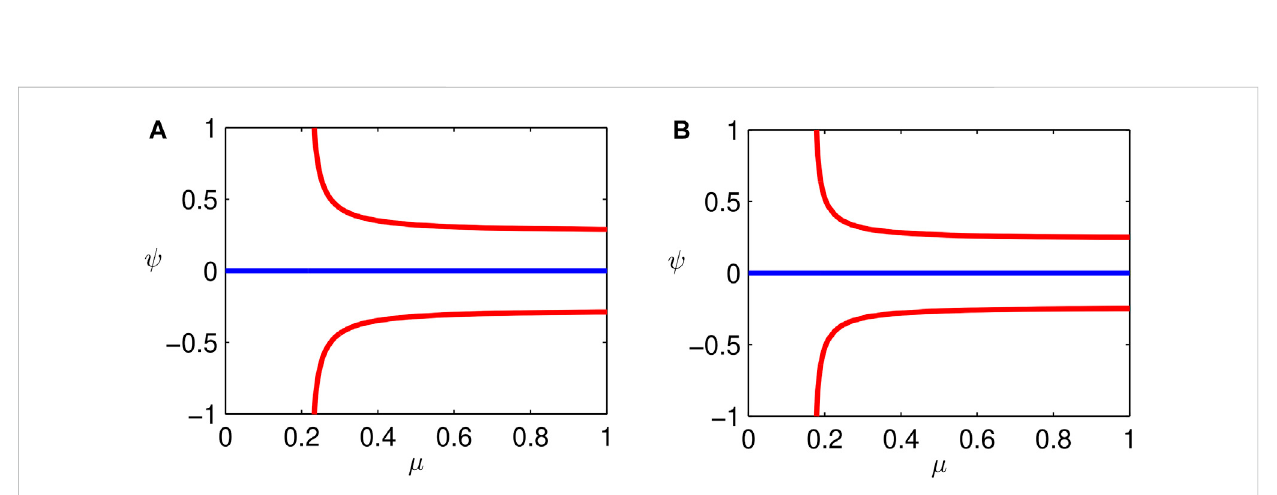
FIGURE 10 Bifurcation diagram between μ and ψ . (A) α =0.0; (B) α